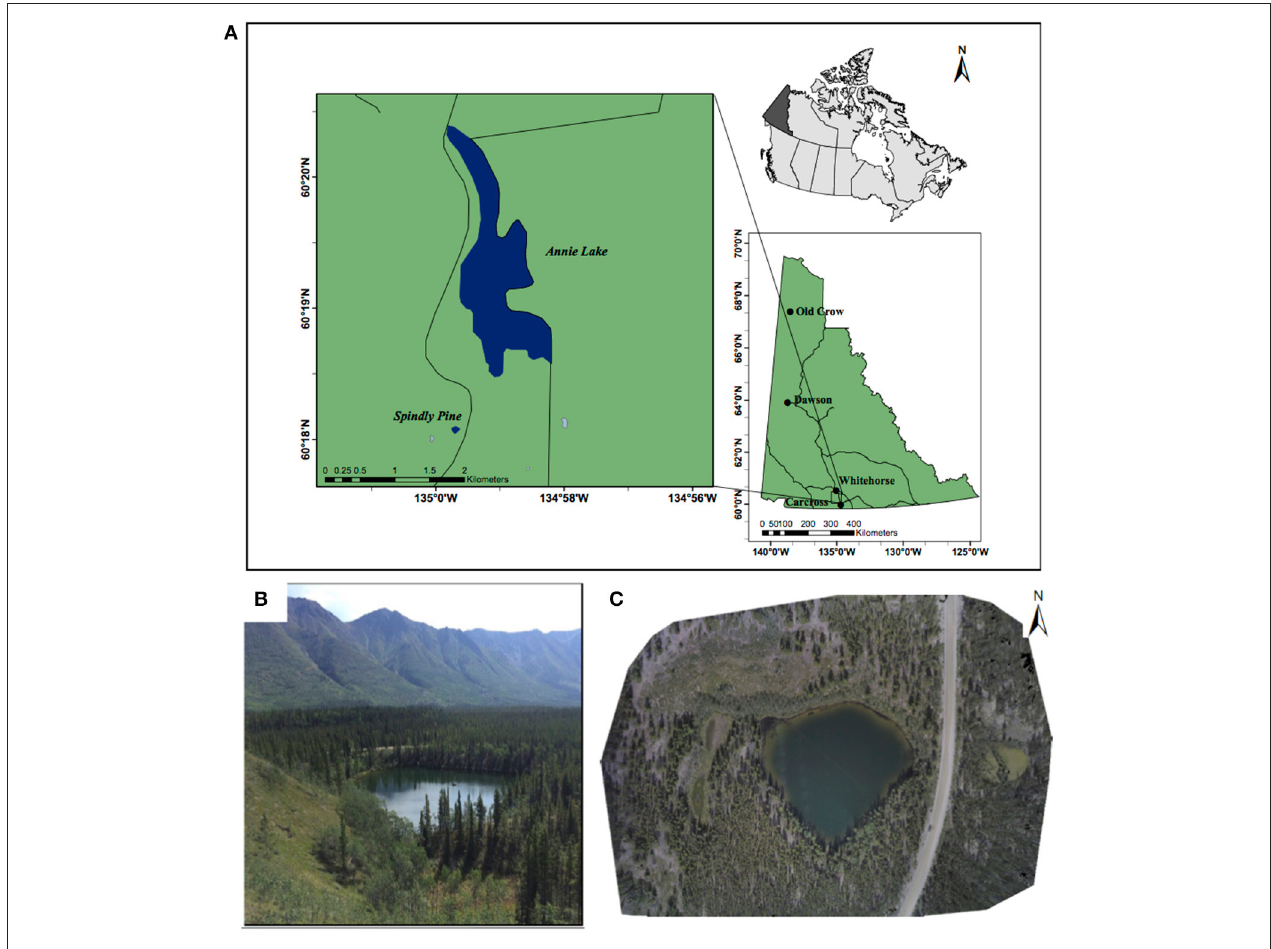
FIGURE 1 | (A) Location of Spindly Pine Lake, Yukon. (B) Low-oblique photograph of Spindly Pine Lake showing the closed basin and lack of inflowing/outflowing streams; (C) Photograph mosaic of the Spindly Pine lake catchment, acquired using an unmanned aerial vehicle.